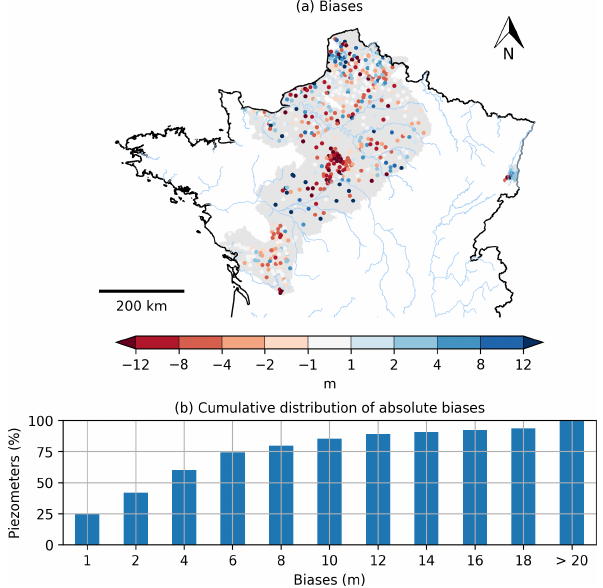
Figure 6. (a) Spatial distribution of the biases calculated between the simulated and observed piezometric heads for the 639 selected piezometers. The grey background colour corresponds to the simu- lated aquifer domain. (b) Cumulative distribution of absolute biases for all piezometers.